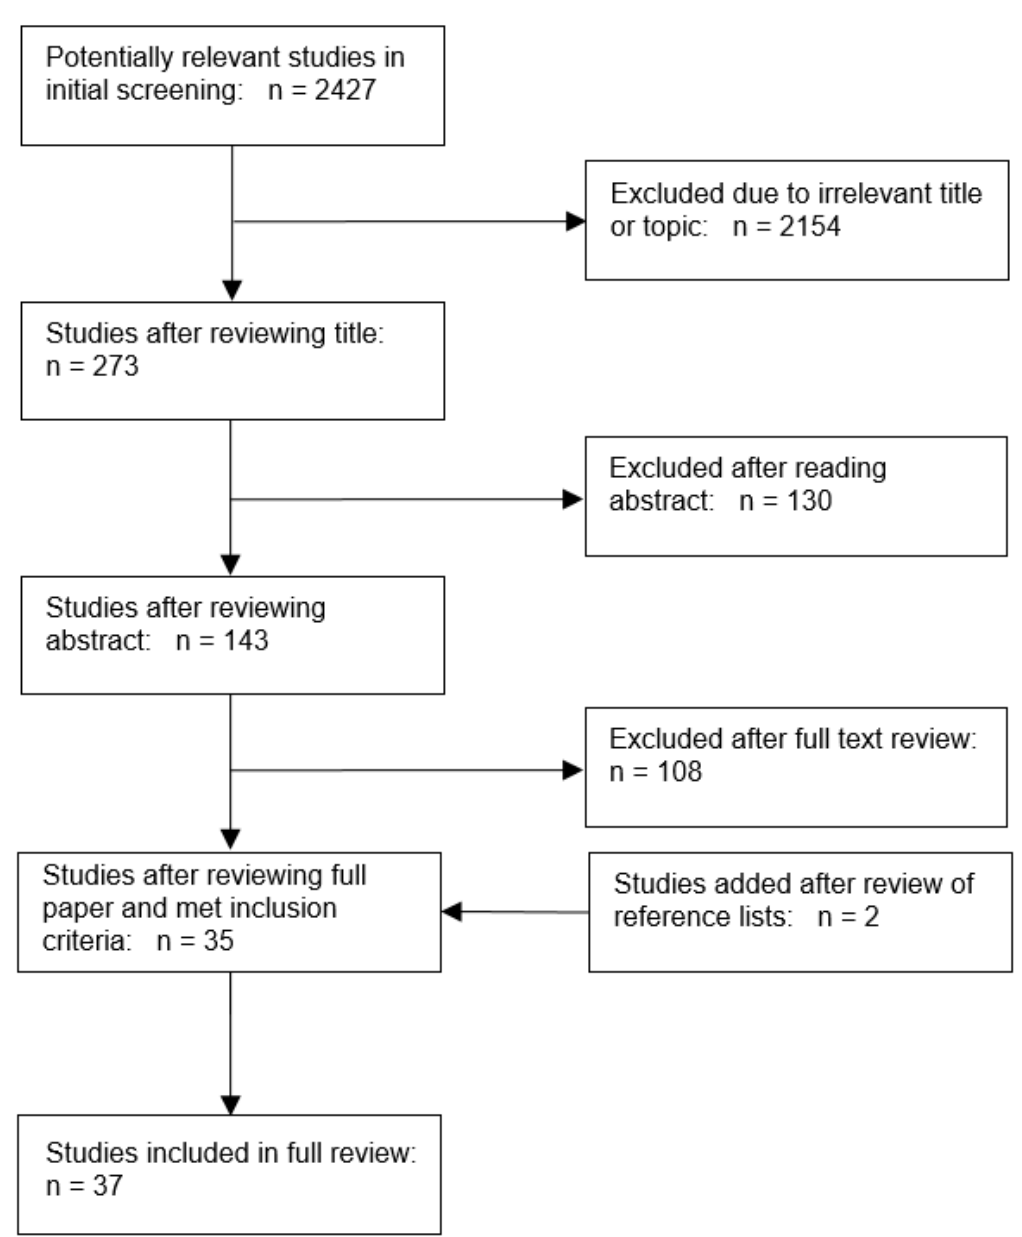
Figure 1. The literature selection process.